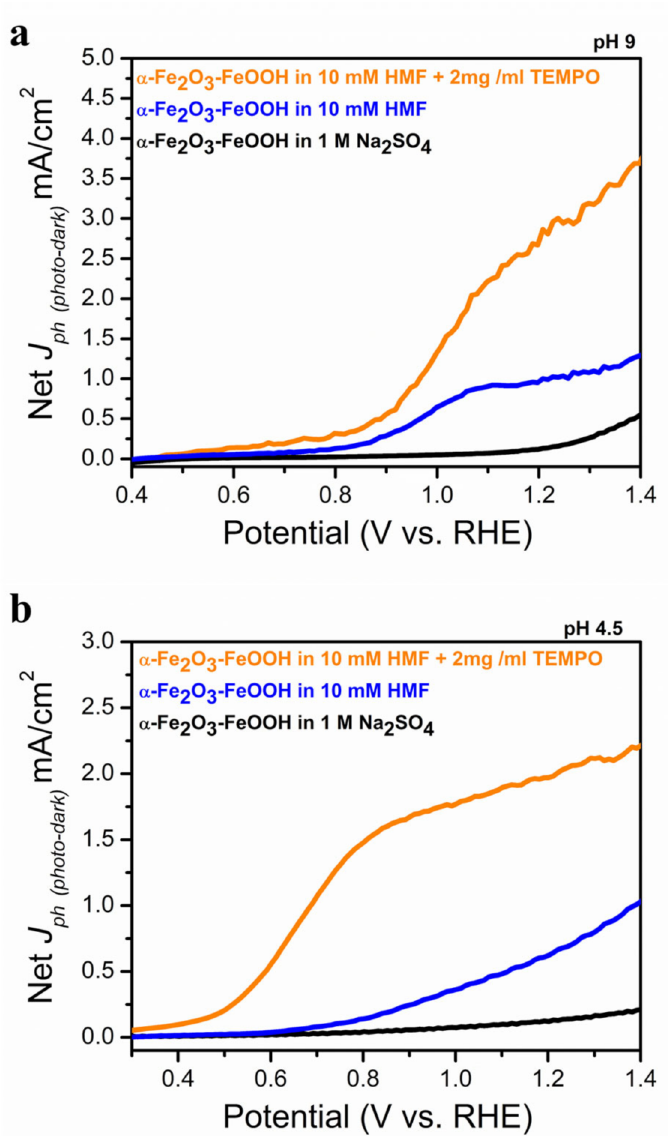
Figure 3. Net photocurrent responses for 5-HMF photooxidation at pH ( a ) 9.0 and ( b ) 4.5. As seen in Table 1, the efficiency of oxidation decreases at lower pH values. At pH 9, 5-HMF was partially converted to a mixture of the route 1 intermediates 2,5-diformylfuran (DFF) and 5-formyl-2-furoic acid (FFCA) (Figure 4), the latter being present in a higher proportion. Reactions performed using FFCA, DFF, and HMFCA, respectively, as sub- strates under the same conditions showed DFF to be most efficiently converted with high selectivity to FFCA. On the other hand, HMFCA and FFCA were partly converted, but with high selectivity to FDCA. In all the experiments starting at pH 9.0, the pH was decreased to 5.0 (pH 6 in case of 5-HMFCA). The corresponding CA and current potential curves shown in Figures S5b–d and S6, respectively, indicate that the FFCA oxidation step is the slowest, in accordance with the previous report [5]. This corresponds to the incident photon-to-current efficiency of 6.07% and the Faradic efficiency of